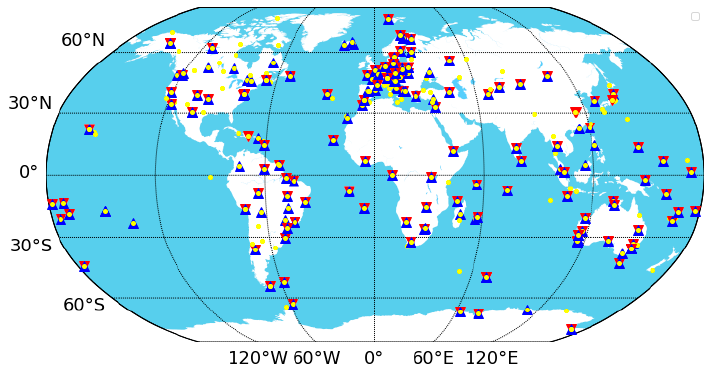
Figure 6. Global distribution of the stations in the fractional cycle bias (FCB) estimation network for GPS (yellow), BDS-2 (red), and Galileo (blue).